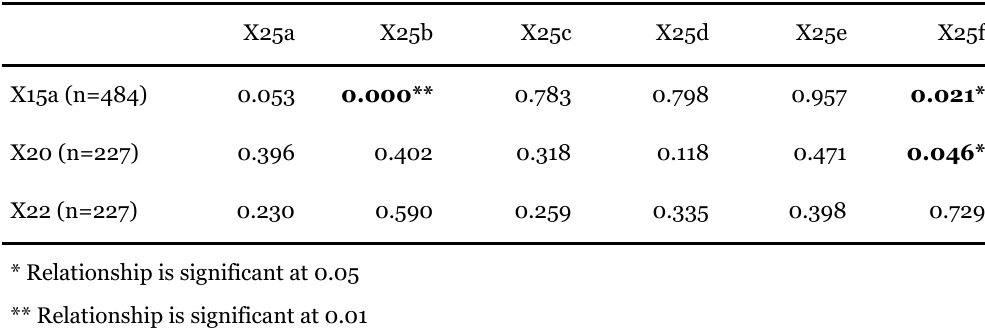
P-Values of The Chi-Squared Tests for Independence Between Accessibility Requirements and e- Learning Participation, Dropping Out and Satisfaction